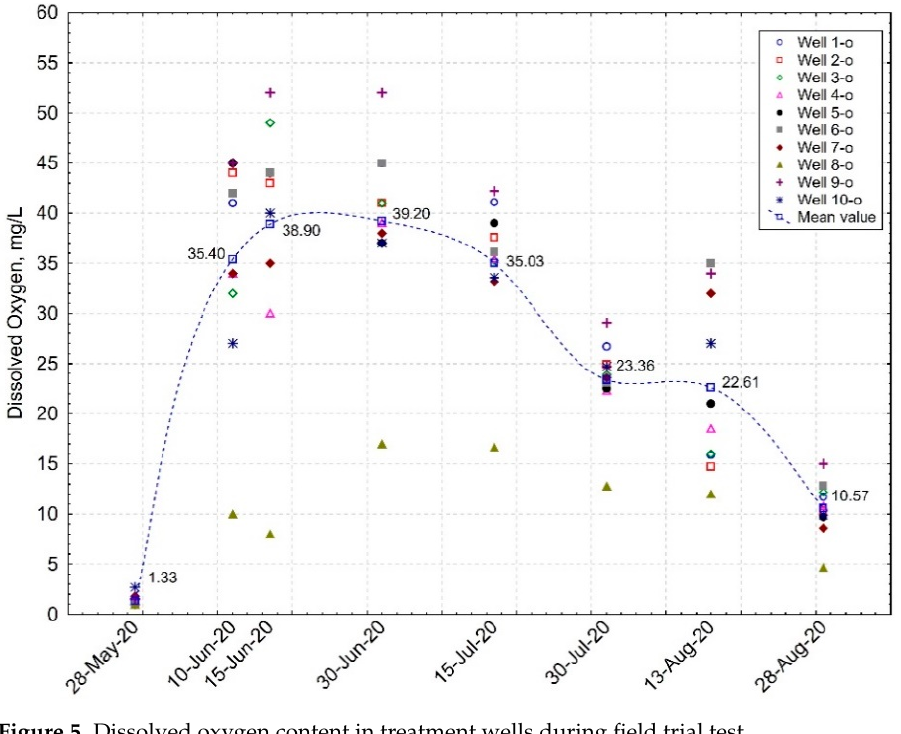
Figure 5. Dissolved oxygen content in treatment wells during field trial test.